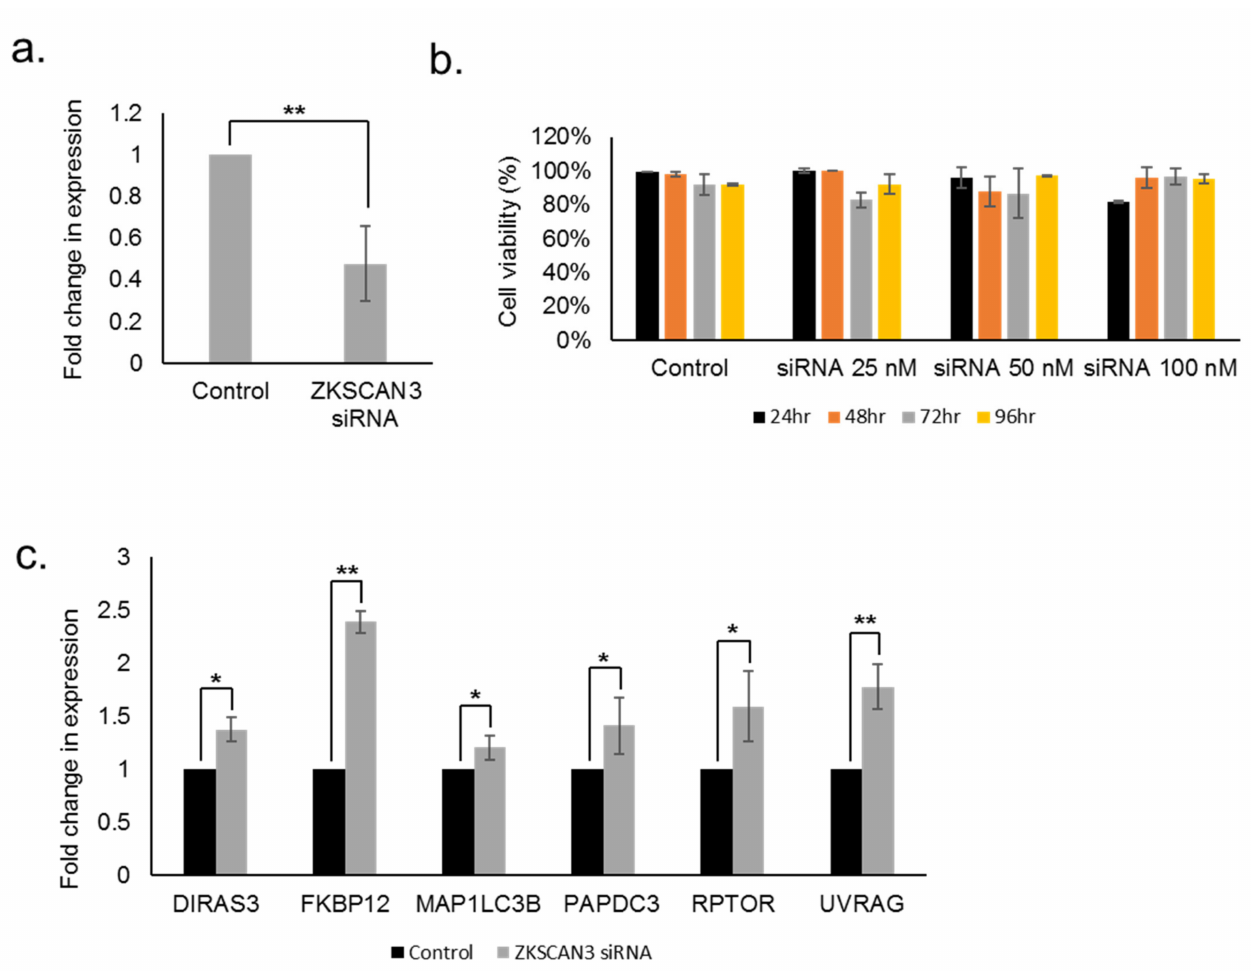
Figure 2. Expression of ZKSCAN3 and downstream targets upon knockdown of ZKSCAN3 in the RPE. ( a ) qRT-PCR analysis of ZKSCAN3 expression upon ZKSCAN 3 siRNA ( b ) Cell viability assay upon ZKSCAN3 siRNA treatment ( c ) qRT-PCR analysis of the following ZKSCAN3-regulated lysosomal autophagy genes. All data are presented as mean ± standard deviation. Student’s t-test (two tailed) was used for analysis p -value. The p -value is stated as * p < 0.05, ** p <